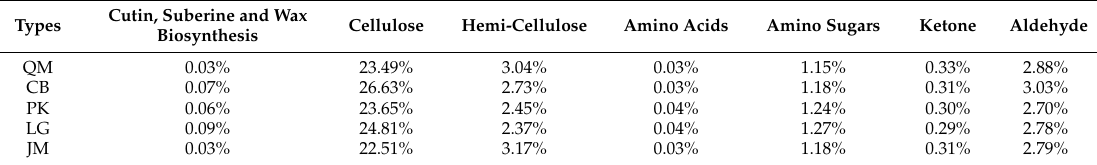
Table 4. The relative abundance of genes corresponding macro-molecular compounds metabolism of different soil organic carbon chemical functional groups.